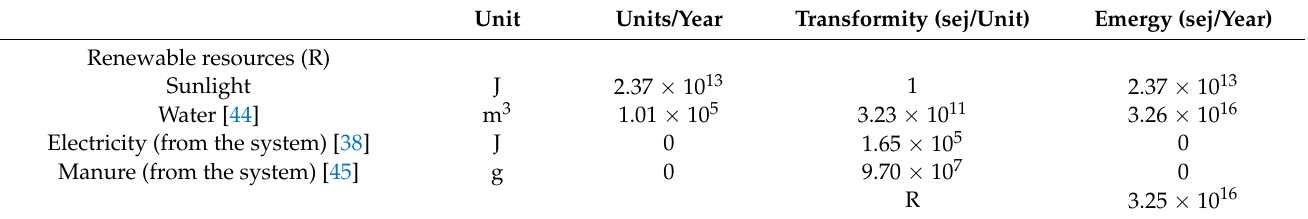
Table 2. Emergy calculation of biogas subsystem